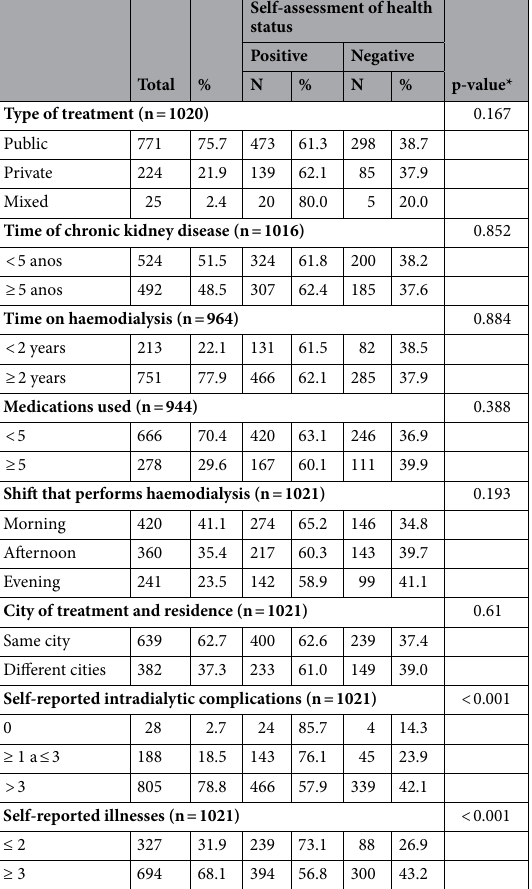
Table 2. Distribution of clinical and treatment characteristics according to self-assessment of health status.